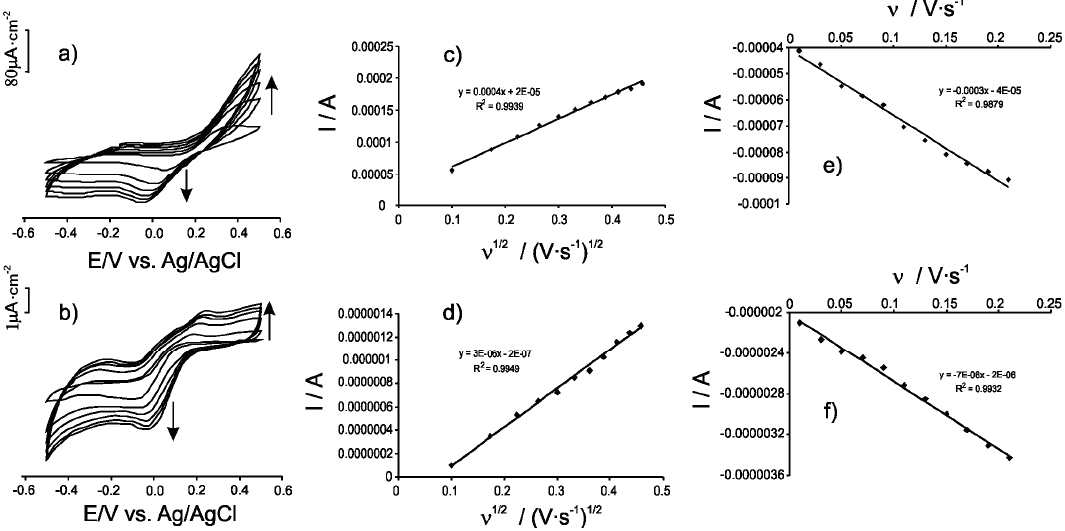
-LB registered at different scan rates; ( b ) 2 -CPE registered at different scan rates; ( c ) Plot of I 2 -LB; ( d ) Plot of I versus ν 1/2 for Ty/LuPc 2 pa -LB; ( f ) Plot of I versus ν 1/2 for Ty/LuPc 2 pc